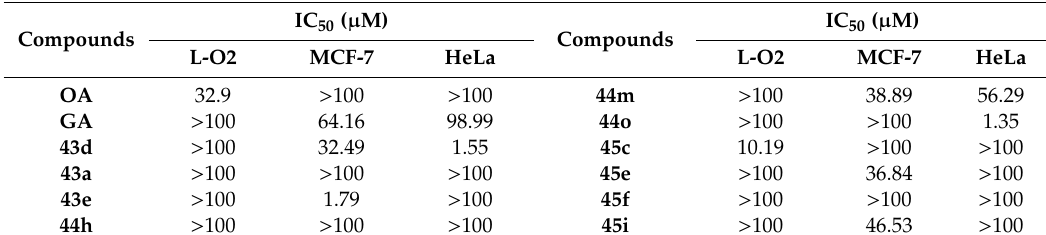
Table 4. IC 50 values of oleanolic acid (OA), glycyrrhetinic acid (GA) and their derivatives towards L-O2, MCF-7 and HeLa cells